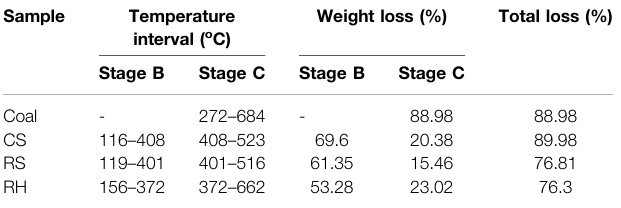
TABLE 2 | Temperature interval and weight loss of coal and biomass